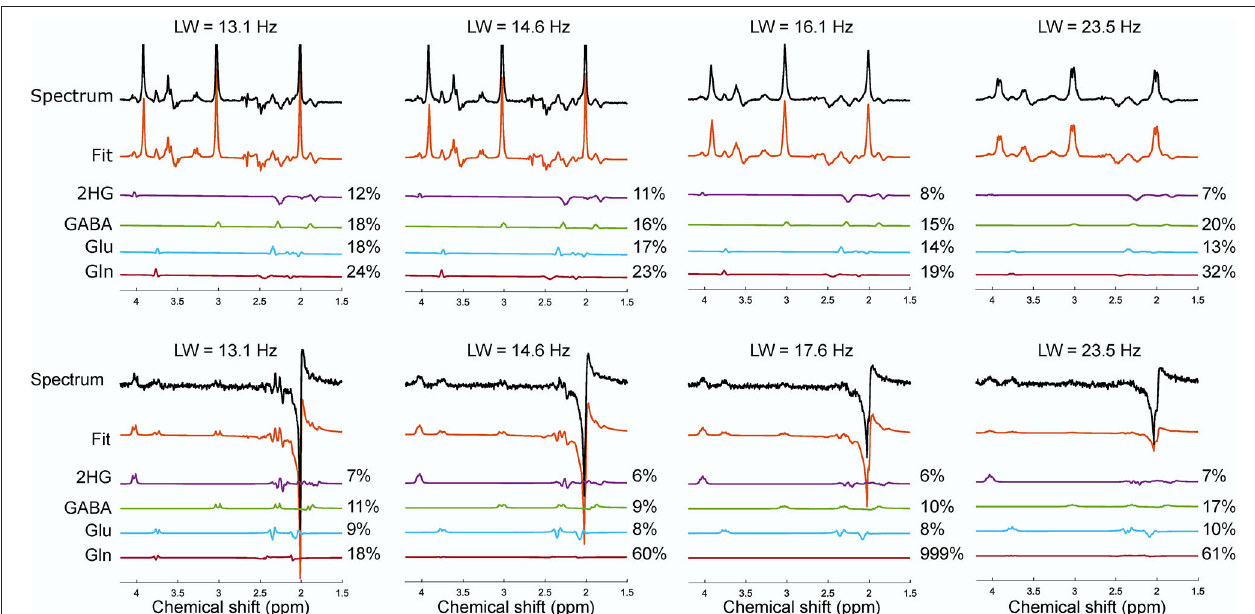
FIGURE 5 | The effect of the increase in linewidth on the reported CRLB (%) from the phantom with NAA, Cr, 2HG, Glu, Gln, GABA, myo-inositol for sLASER (top row) and MEGA-sLASER (bottom row). The spectra with their corresponding fit for 2HG and other overlapping metabolites of GABA, Glu and Gln from sLASER and MEGA-sLASER measurements at different linewidth are shown. Number of averages for sLASER and MEGA-sLASER were 32 and 64, respectively. The spectra were scaled to the standard deviation of the noise.